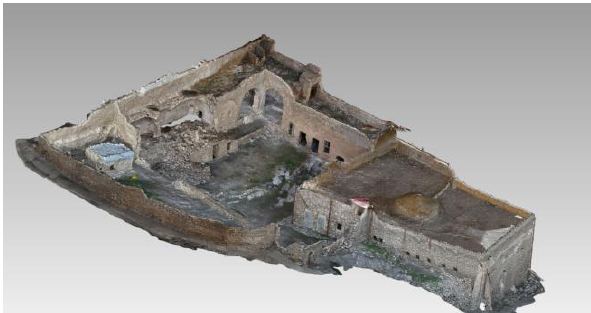
Figure 9. Example of the textured model created from photogrammetric data set with missing parts supplementation, view from the